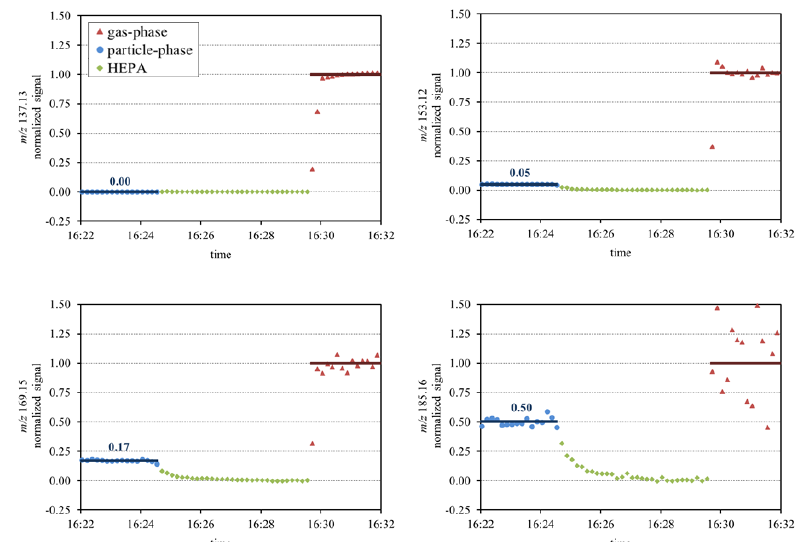
) , m/z 153.12 (C 10 H 17 O + ) , m/z 169.15 (C 10 H 17 O + ) and m/z 185.16 (C 10 H 17 O + ) 17 1 2 3 , C 10 H 17 O + and C 10 H 17 O + signals detected in the particulate phase increases from 0.05 to 0.17 1 2 3